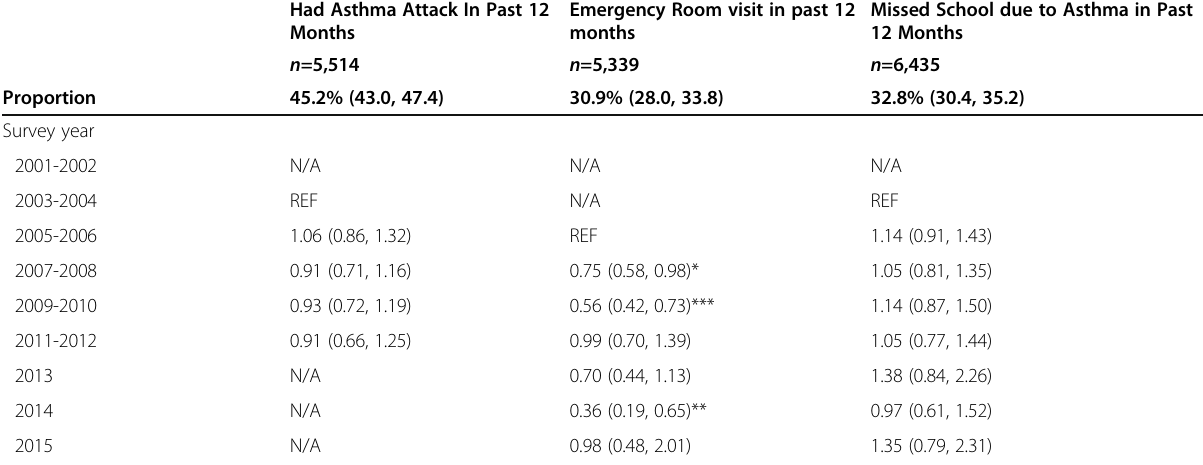
Table 4 Logistic Regression for Asthma Outcomes (Continued) Had Asthma Attack In Past 12